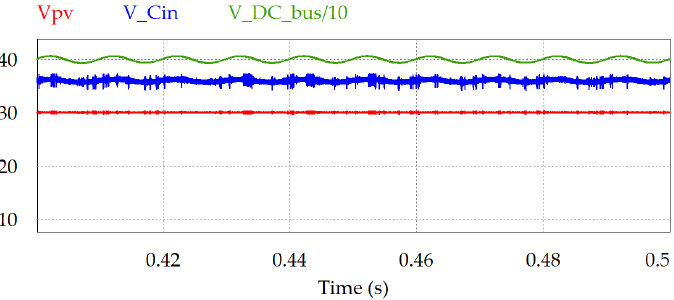
Figure 17. Simulation results of operation mode 1, PV voltage V PV —the voltage across input capacitor V C —DC bus voltage V DC _ bus / 10. in